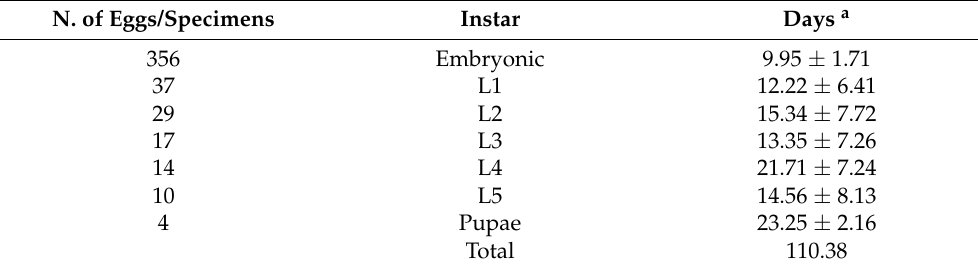
Table 3. Aclees taiwanensis preimaginal instar durations under laboratory conditions.